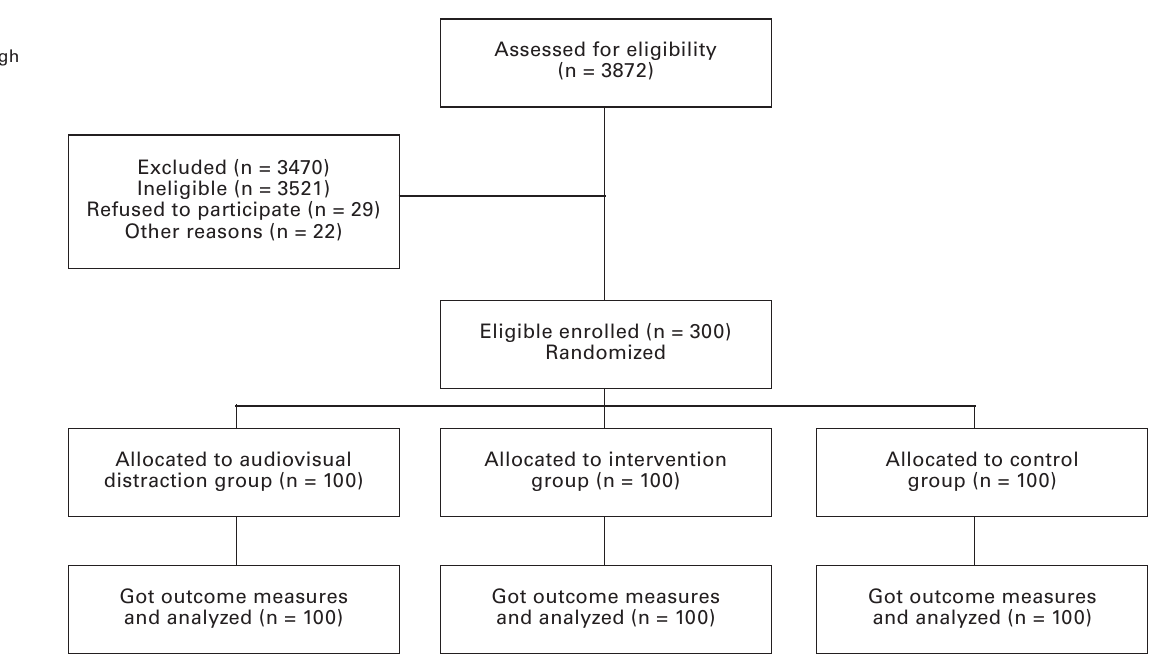
8 2.32 in the audiovisual distraction and inter- vention groups, respectively) ( P = 0.031 <0.05) (tab. 5). No indicators of patient painful experi- ence were significantly different in the audio - visual distraction and intervention groups, al- though audiovisual distraction patients were somewhat more likely to have a higher VAS score during the procedure ( P = 0.613 >0.05). Pain score of the control group was significantly higher than the audio visual distraction and inter- vention groups ( P = 0.047, 0.013 <0.05). However, the statistical differences are not obvious in means and 95% confidence intervals (tab. 6).